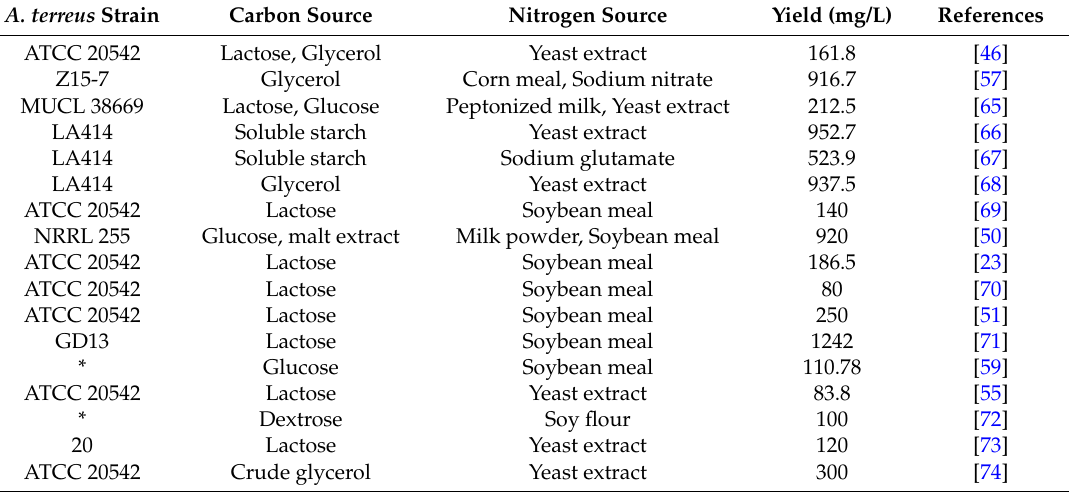
Table 2. Carbon and nitrogen sources in submerged fermentation (SmF) of A. terreus